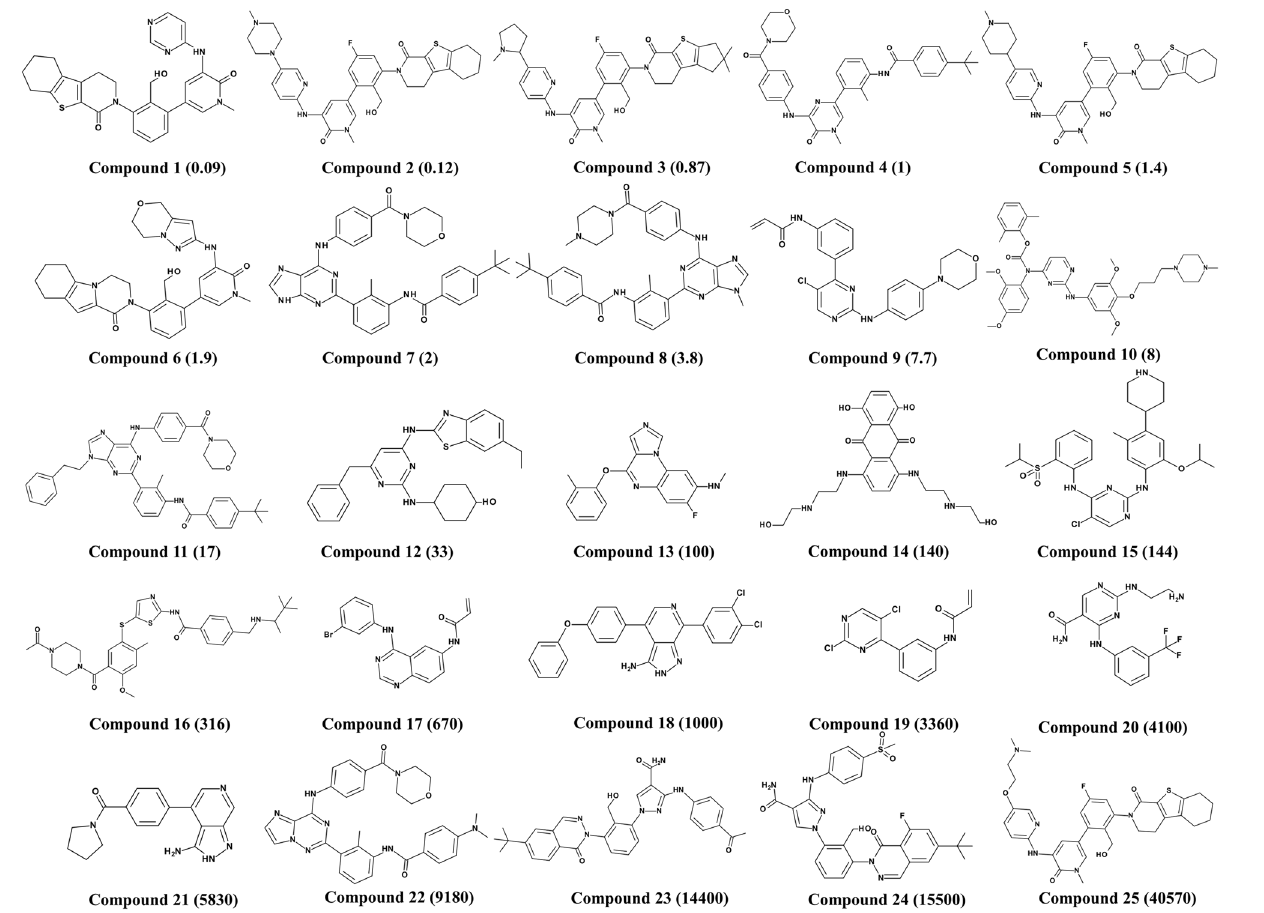
Fig 1. 2D Chemical structures of 25 Btk inhibitors in the training set used for hypothesis generation along with their IC 50 values.